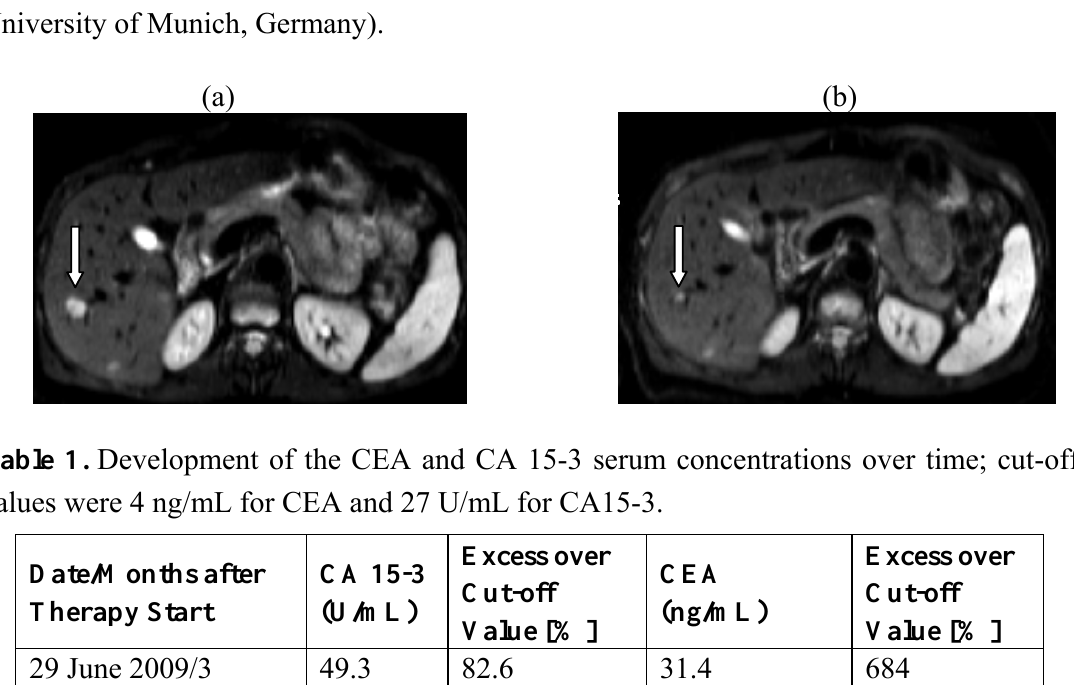
Figure 1. Diffusion-weighted MRI of the liver showing two metastases in the right lobe in ( a ) June 2009, and ( b ) February 2010. One metastasis (arrow) decreased from 15 mm in diameter to 7 mm, while the other remained unchanged (courtesy of Prof. Dr. E.